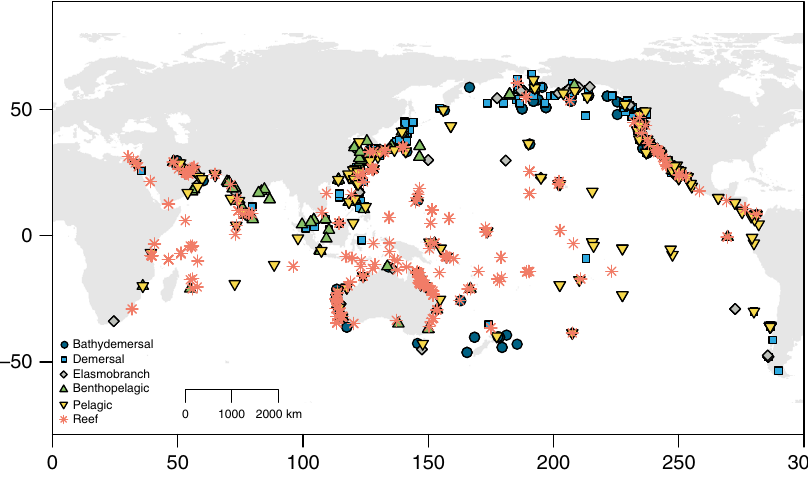
Fig. 1 Sampling locations of 1402 fi sh populations in the Indo-Paci fi c region. The symbol types denote six groups of fi